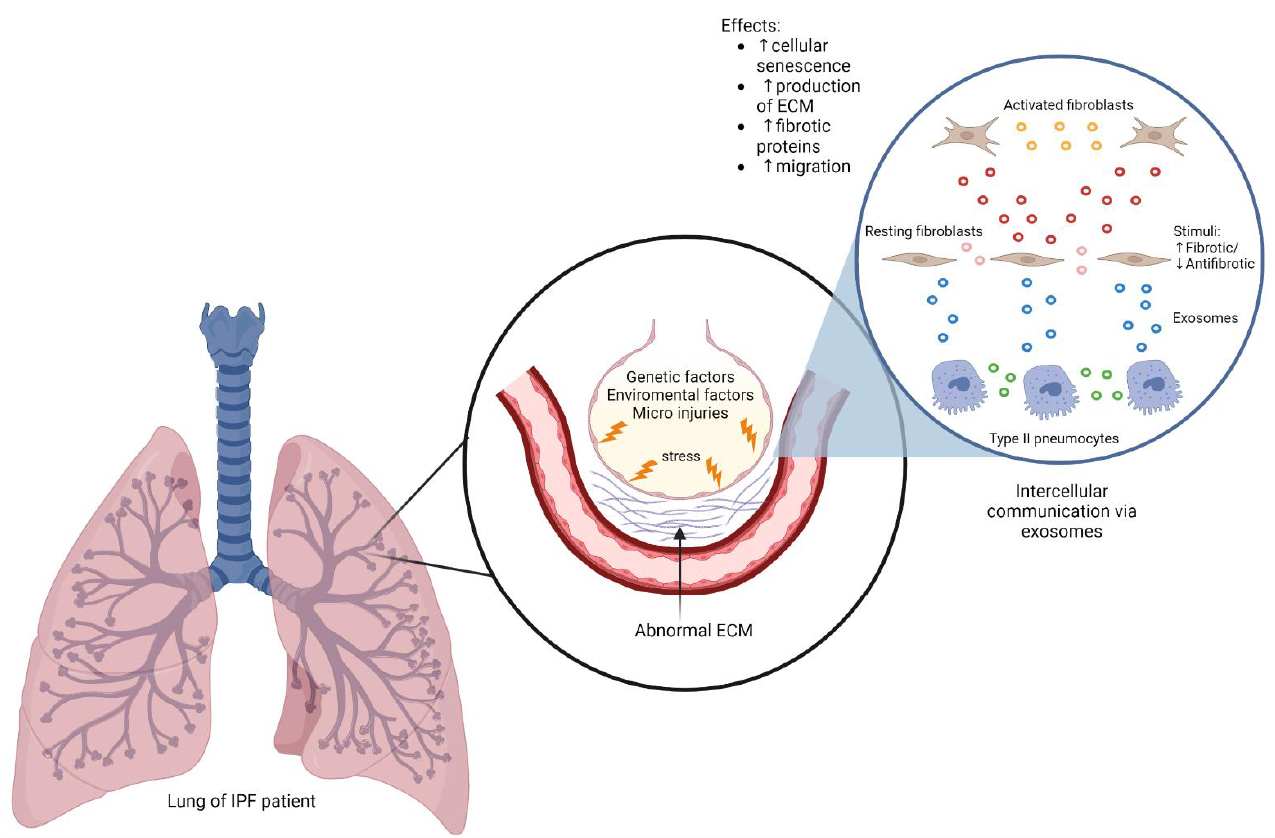
Figure 2. Abnormal cellular communication during IPF. The combination of risk factors and direct injuries on the alveolar epithelium causes an increase in stress. Type II pneumocytes are involved in repair mechanisms, however, aberrant stimuli induce the synthesis of pro-fibrotic factors and through intercellular communication mediated by EVs that activate fibroblasts promoting the increased production of abnormal ECM and loss of functional tissue on the parenchyma.